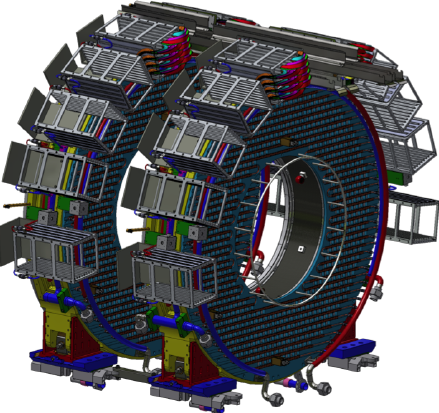
Figure 9. CAD drawing of the calorimeter disks. Calorimeter innermost (outermost) radius is of 351 mm (670 mm). Layout of the digitization crates is also shown.